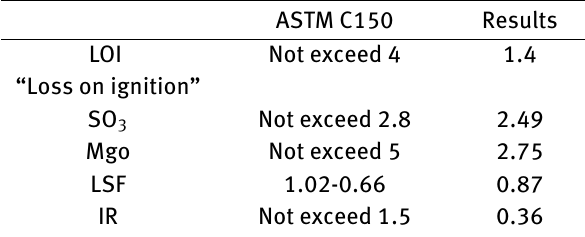
Table 1: Chemical composition of Portland cement